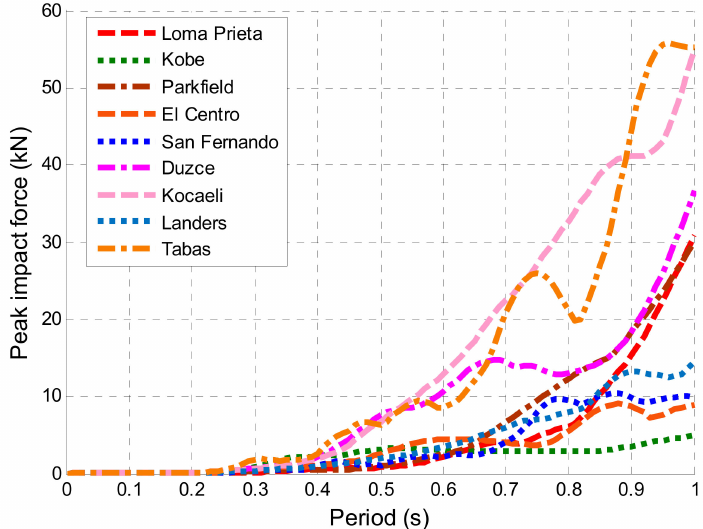
Figure 4. Peak impact force with relation to natural period of the left building under di ff erent